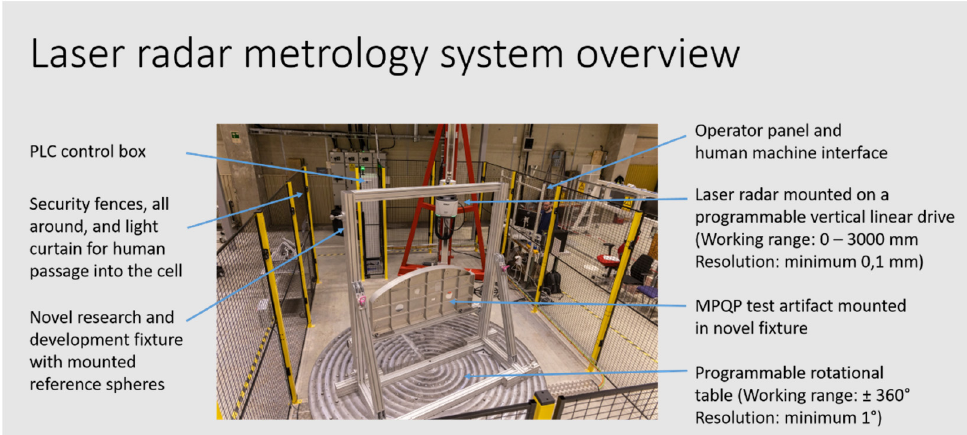
Figure 21. Principal construction of the laser radar measuring cell.